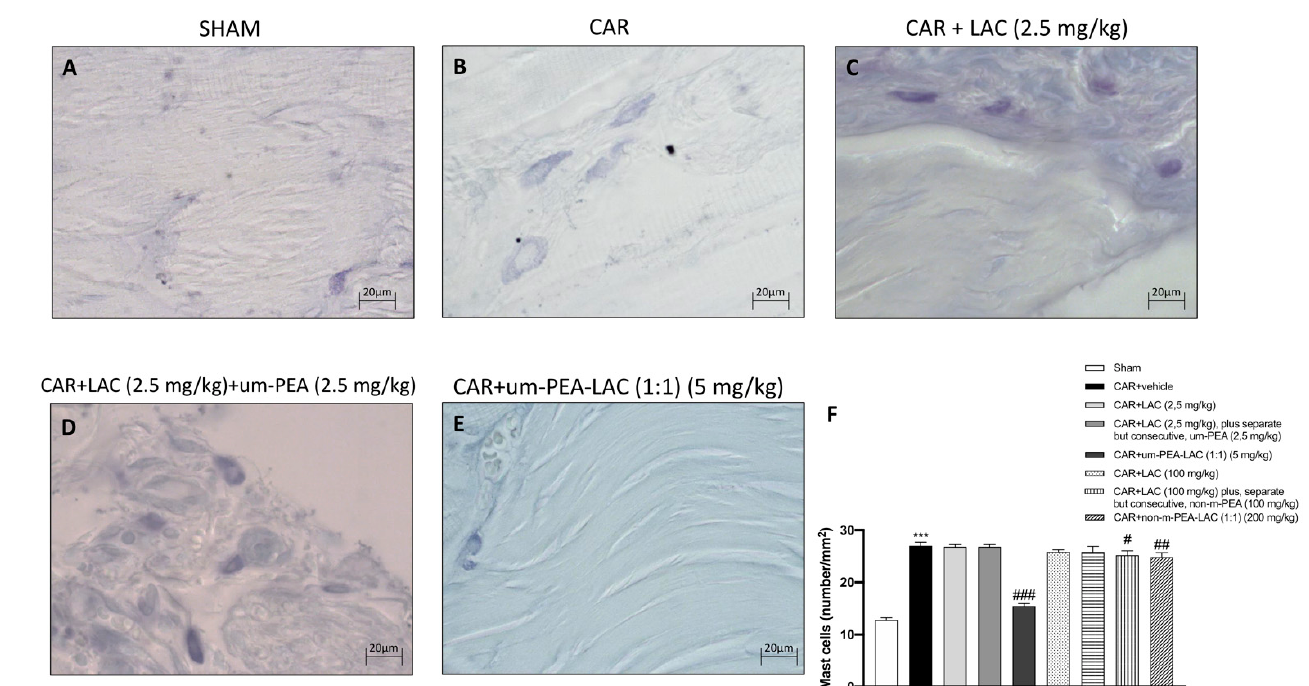
Figure 3. Efficacy of um-PEA and LAC treatment on the mast cells number. An increased number of mast cells was found in tissue from CAR-injected animals ( B , F ), compared to the control group ( A , F ). A decreased number of mast cells was identified in paw tissues obtained from CAR animals treated with um-PEA and LAC (5 mg/kg) ( E , F ) and to a lesser extent in CAR + LAC (100 mg/kg) plus, separate but consecutive, non-m-PEA (100 mg/kg) and CAR + non-m-PEA-LAC groups (1:1) (200 mg/kg) (data not shown). Other remaining treatments did not show any significant reduction ( C , D , F, and data not shown). Data are representative of at least three independent experiments. Values are means ± SEM. One-Way ANOVA test. *** p < 0.001 vs. sham; # p < 0.05 vs. CAR; ## p < 0.01 vs. CAR; ### p < 0.001 vs. CAR.